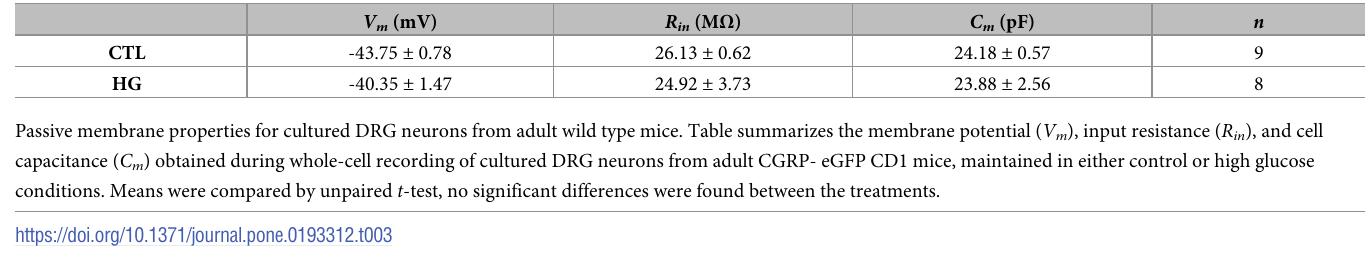
Table 3. Passive membrane properties for cultured DRG neurons from adult wild type mice.